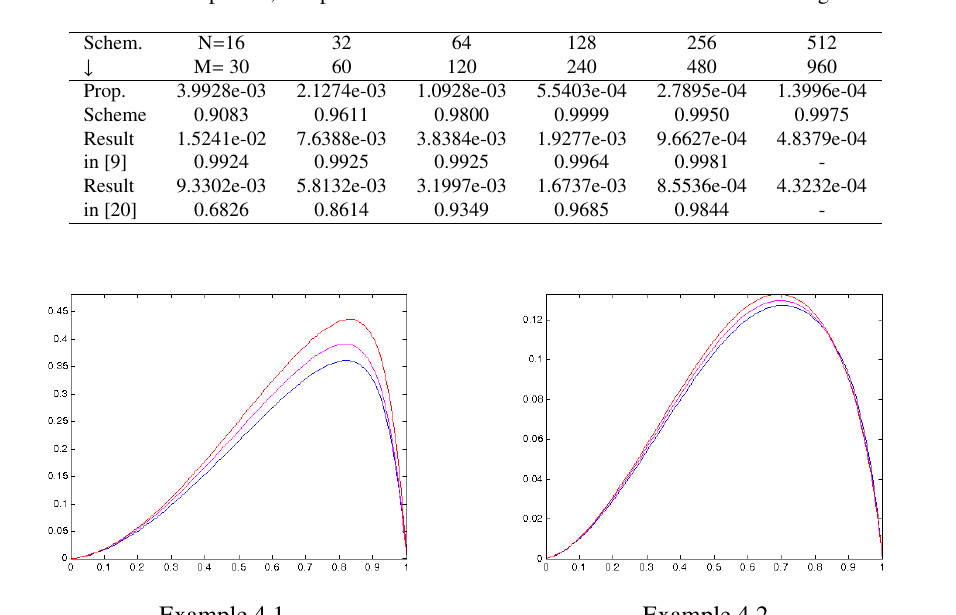
Figure 3. E ff ect of delay parameter on solution δ = 0 , 0 . 3 ε, 0 . 6 ε in increasing order on figures, for ε = 2 − 2 and η = 0 . 5 ε .